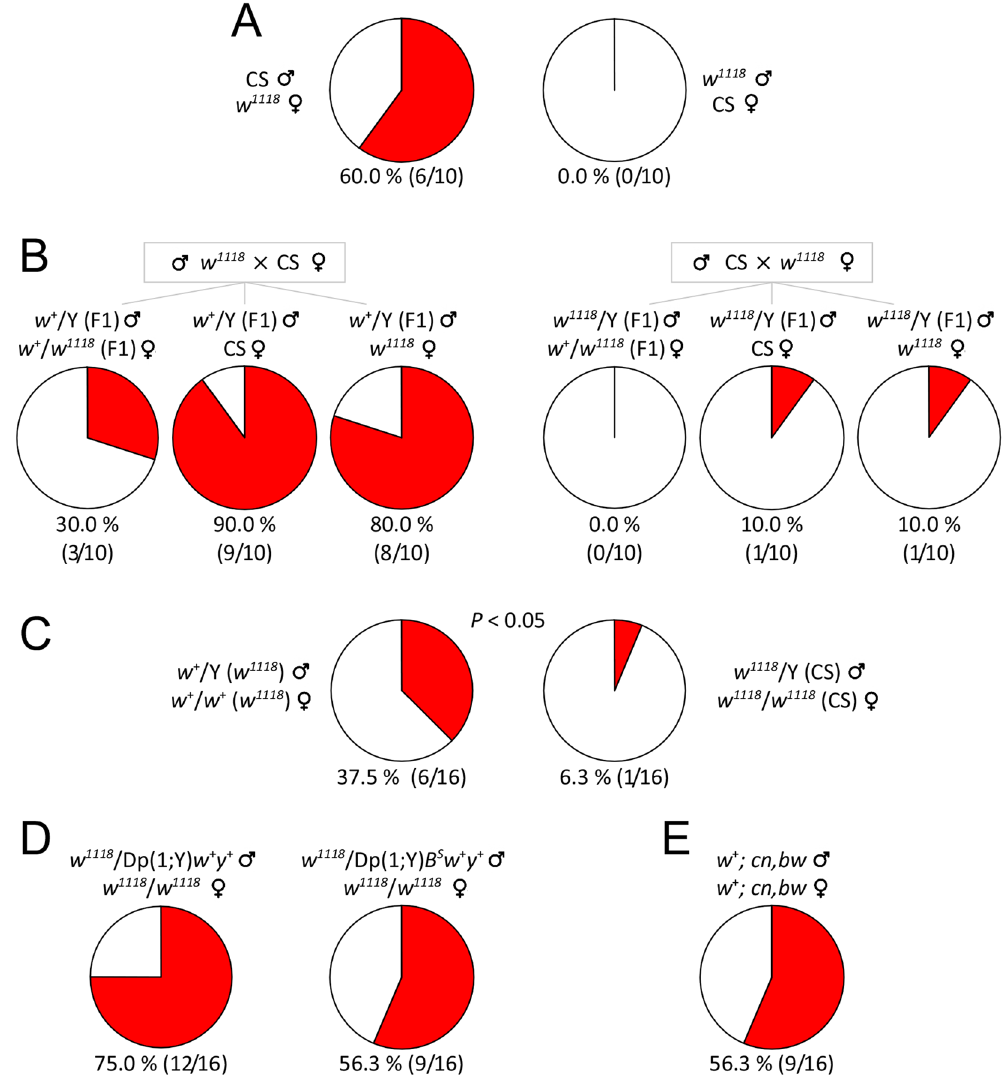
Figure 3. w + allele was associated with copulation success. ( A ) Copulation success between CS males and w 1118 females, and between w 1118 males and CS females. ( B ) Copulation success between F1 males and three types of females (See Methods and text). ( C ) Copulation success of w + ( w 1118 ) and w 1118 (CS) flies in which different w alleles are exchanged between CS and w 1118 by serial backcrossing for ten generations. P value from Fisher’s exact test. ( D ) Copulation success of flies with w + duplicated to the Y chromosome. ( E ) Copulation success in w + ; cn , bw (white-eyed) flies. For all the experiments, copulation success is indicated as red in the pie chart. Sexual activities of flies was observed within 60 minutes in the circular arenas. Numbers of tested pairs and numbers of successful copulation are shown. Fly sex is indicated as (male) and